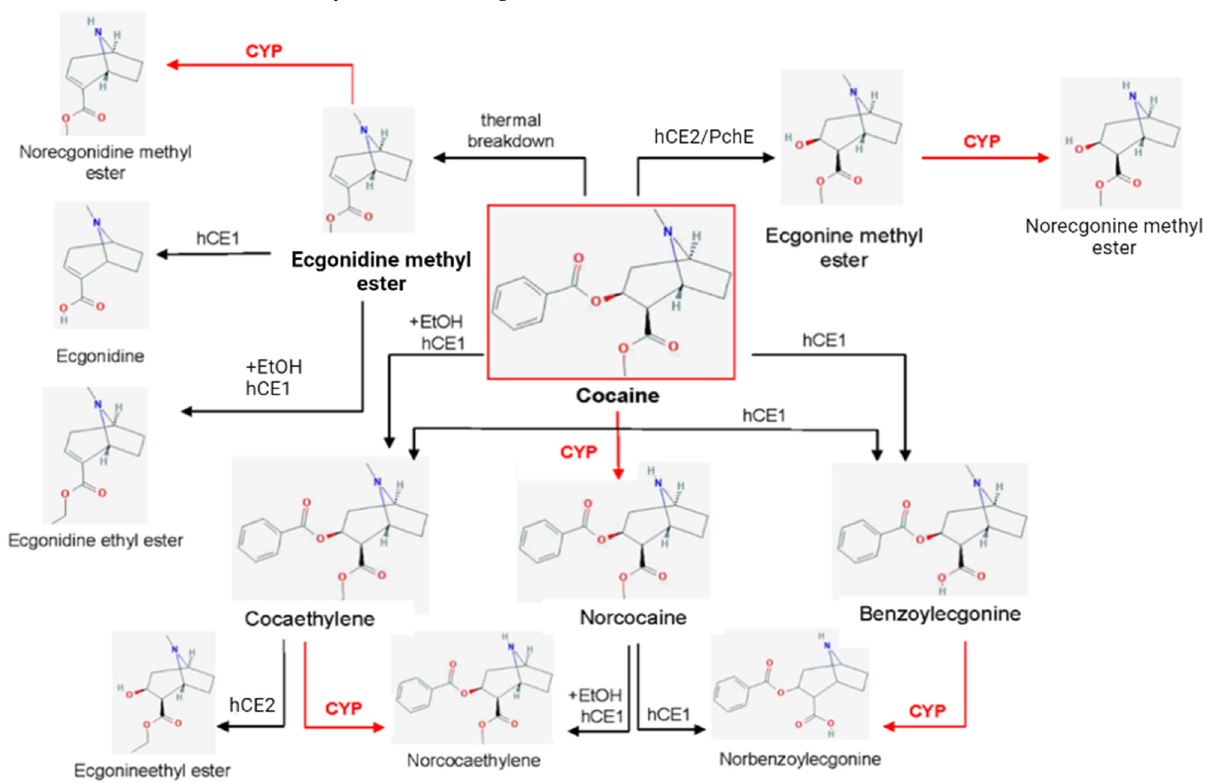
Figure 2. Scheme representing cocaine metabolism pathways with particular reference to the role of cytochrome 450 (CYP) (based on [77]. EtOH—ethanol; hCE1—human carboxylesterase type 1, hCE2—human carboxylesterase type 2, PchE—pseudocholinesterase.